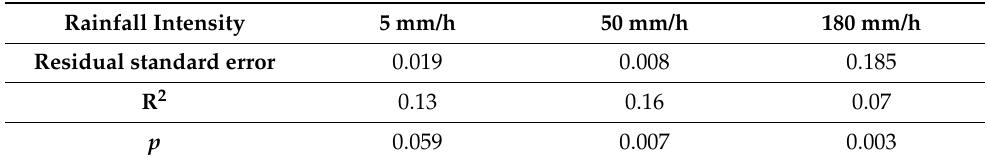
Table 3. Results of the statistical regression analysis of water discharge versus flow accumulation (Figure 11).